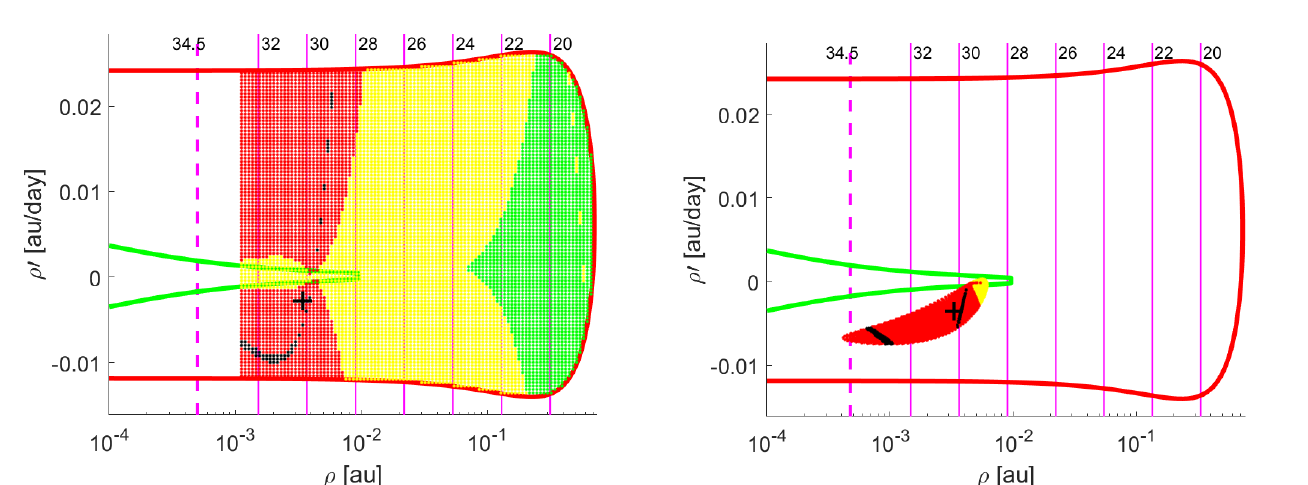
Figure 1. Tool 1 tested on tracklets of four observations (left) and seven observations (right) for asteroid 2008TC 3 .